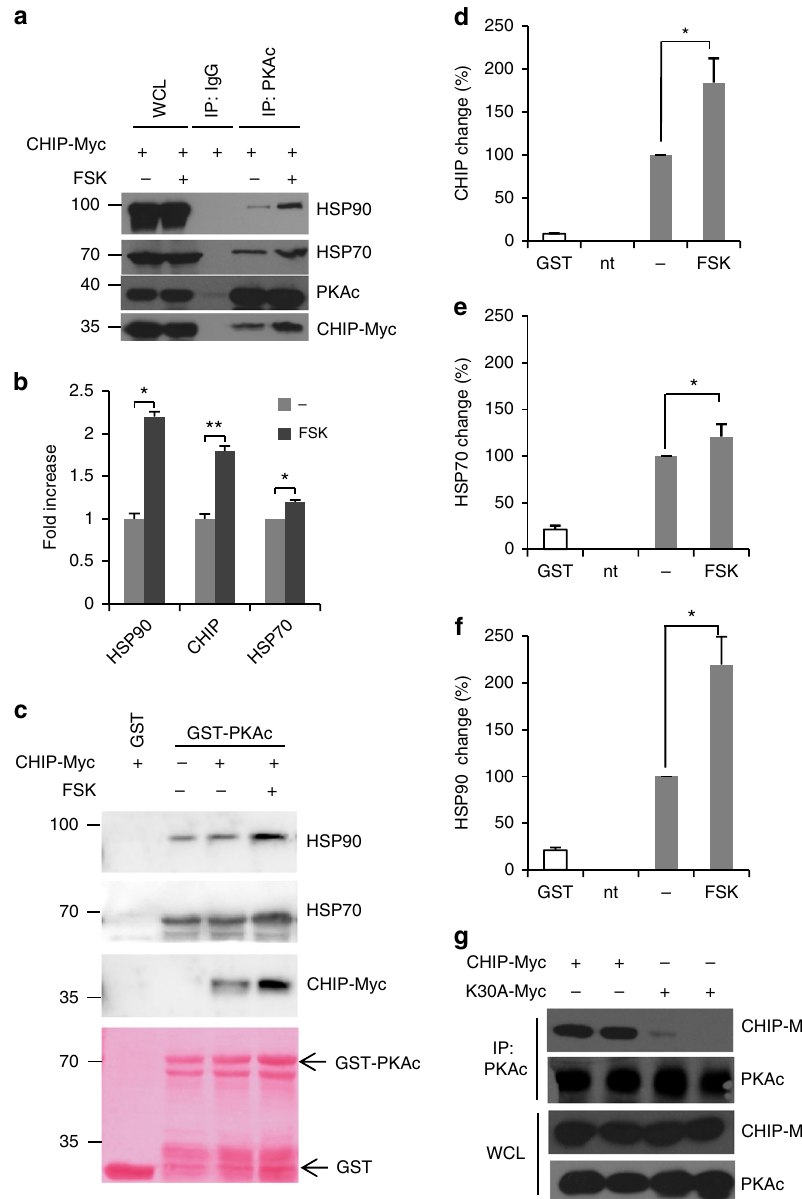
Fig. 2 Recruitment of CHIP/HSPs complex to PKAc. a HEK293 cells were transiently transfected with CHIP-Myc vector, treated for 30 min with FSK and lysed. Lysates were immunoprecipitated with anti-PKAc antibody. The precipitates and an aliquot of lysates were immunoblotted with anti-HSP70/90, anti-PKAc and anti-myc antibodies. b Quantitative analysis of the experiments shown in a . A mean value ± S.E.M. of three independent experiments is reported. Student ’ s t test, * p < 0.05. c GST-PKAc pull-down experiments from HEK293 lysates expressing CHIP-myc and HSP70-V5. Ponceau staining (lower panel) and immunoblot analysis of HSP90, CHIP and HSP70 are shown. d – f Quanti fi cation levels were normalized against the basal level of the nontreated GST-PKAc samples (nt nontransfected cells). Representative results of fi ve independent experiments (mean± SEM; statistical test: ANOVA, * p < 0.05). g Lysates from cells transiently transfected with CHIP-myc vector (wild type or K30A mutant) were subjected to immunoprecipitation